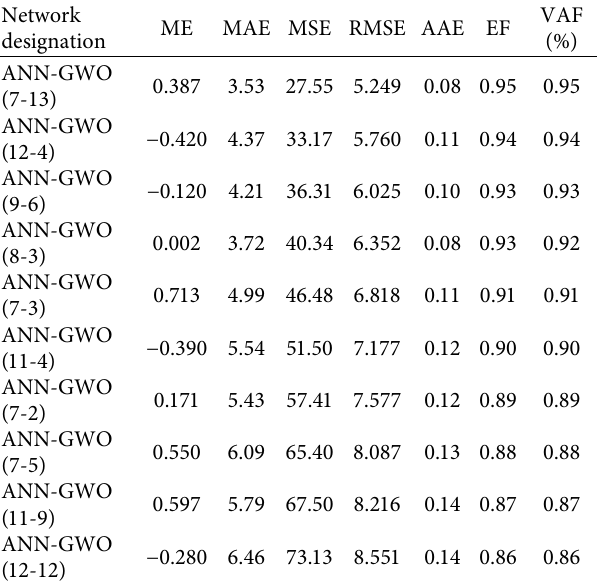
Table 4: Statistical indexes of the top 10 models in the neural networks on training